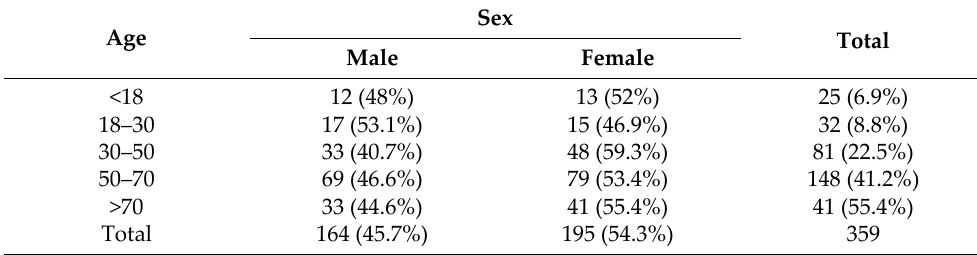
Table 2. Basic information about residents.